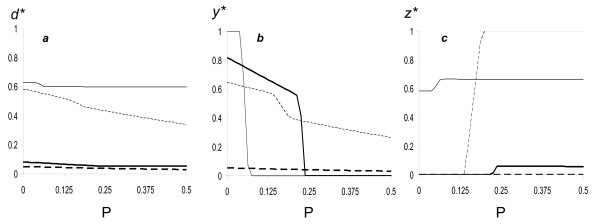
Effects of parameters on optimal dispersal levels for Model 1. Effects of public good production (P), frequency of cooperators (n) and effective group size (k). Caption a: overall dispersal d*; Caption b: investment in cooperator dispersal y*; Caption c investment in cheater dispersal z*. Thin line: k = 1.2, n = 0.1; dashed line: k = 10, n = 0.1; thick line: k = 1.2, n = 0.9; thick dashed line: k = 10, n = 0.9. Other parameters: c = e = 0.2, Q = 0.2, s = 0.6.